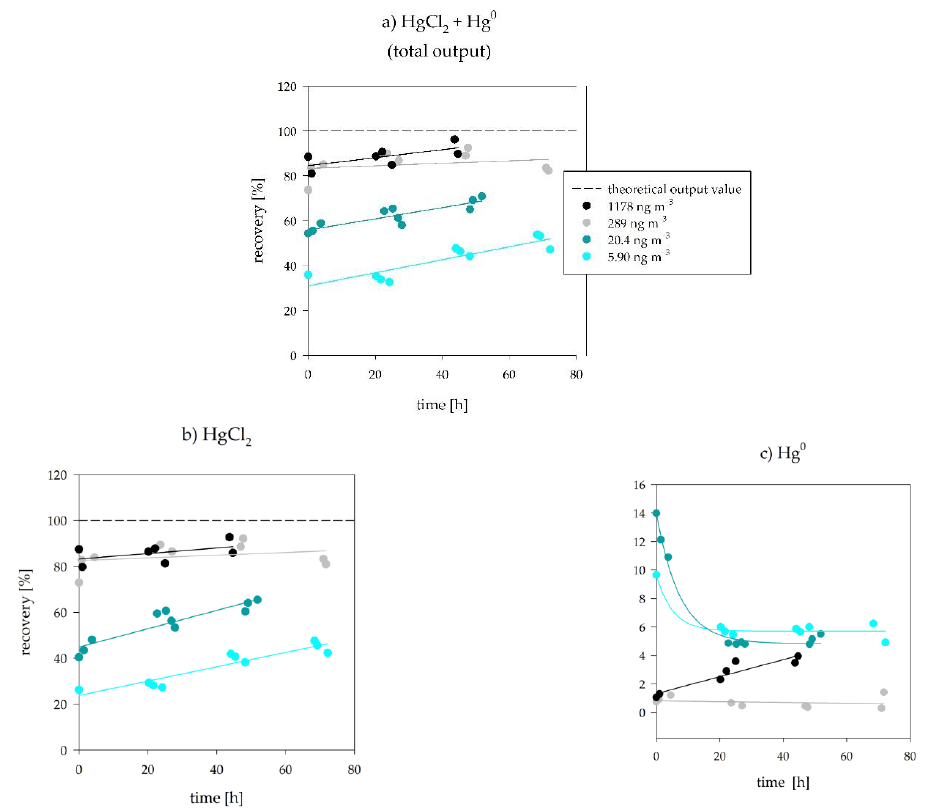
Figure 4. The concentration-dependent response of the HgCl 2 calibrator output during four days of continuous operation. ( a ) shows HgCl 2 plus Hg 0 (total calibrator output), ( b ) shows HgCl 2 , and ( c ) shows the Hg 0 values. The straight line at 100 percent shows a 100% recovery value, to which the experimentally obtained values were compared. The experiment with 1178 ng m − 3 concentration had to be finished after 40 h of operation due to a power supply